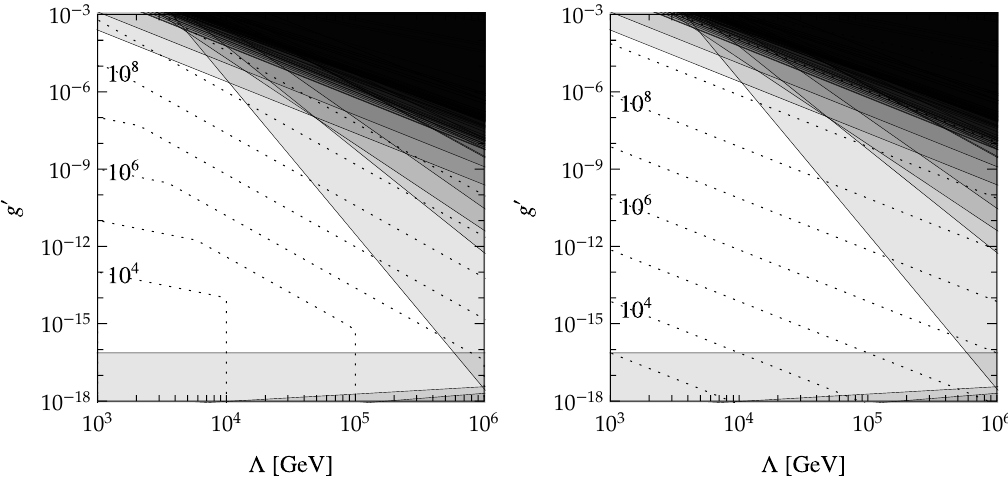
Figure 20 . Same region as in (cid:12)gure 17 (fragmentation during in(cid:13)ation) where we show the contours of the minimum (left) and maximum (right) values of the in(cid:13)ationary scale M I in GeV.